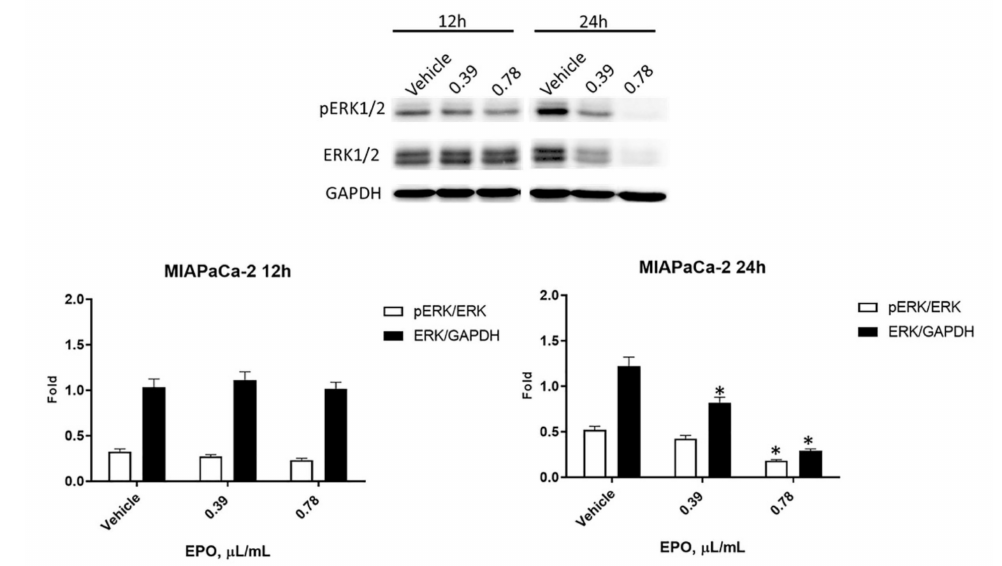
Figure 8. Evaluation of EPO effect in MIAPaCa-2. Western blot analysis of pERK and ERK protein levels in MIAPaCa-2 cells after 12 and 24 h of treatment with EPO. ERK protein expression was normalized to GAPDH protein expression used as loading control; pERK protein expression was normalized to ERK protein expression. Densitometric values shown are the mean ± SD of three separate experiments. * p < 0.05 treated vs. vehicle